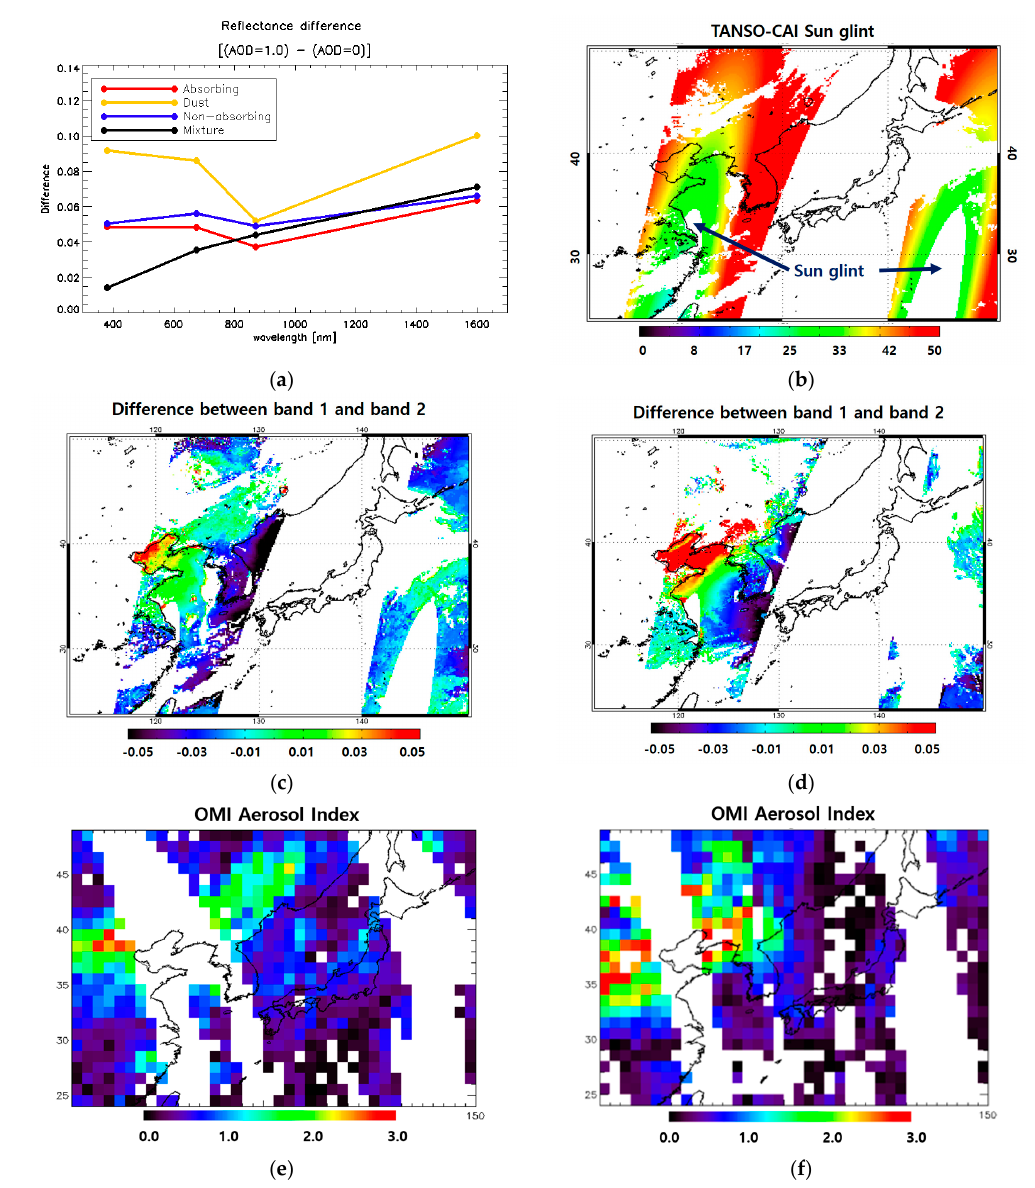
Figure 3. Examples of ( a ) the reflectance differences of TANSO-CAI channels depending on AODs; ( b ) An example of sun glint angle calculated from TANSO-CAI aerosol algorithm on 9 April 2011. The regions where the angle is smaller than 23 ° represent sun glint. Examples of the reflectance differences using bands 1 and 2 from TANSO-CAI with 0.1 ° grid pixel resolution on ( c ) 9 April 2011 and ( d ) 27 April 2012. Images of aerosol index from OMI Level 3 measurements with 1° grid pixel resolution on ( e ) 9 April 2011 and ( f ) 27 April 2012, respectively.